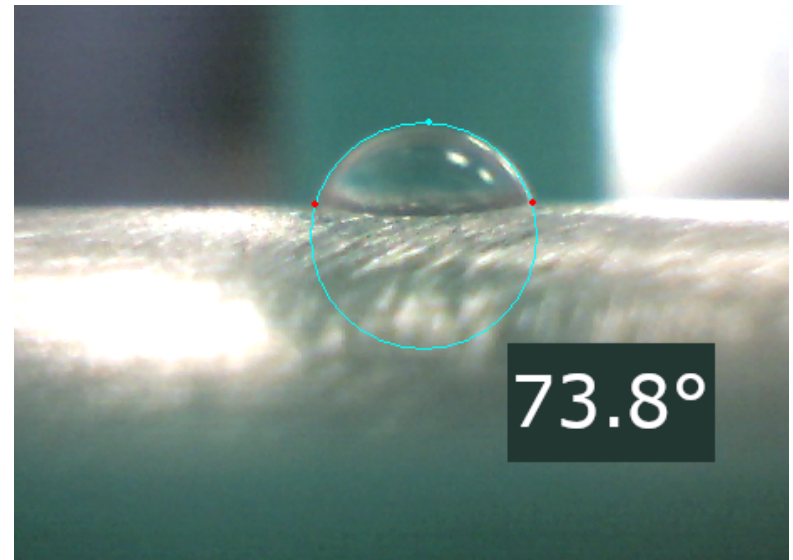
Figure 9. IN150 surface contact angle.